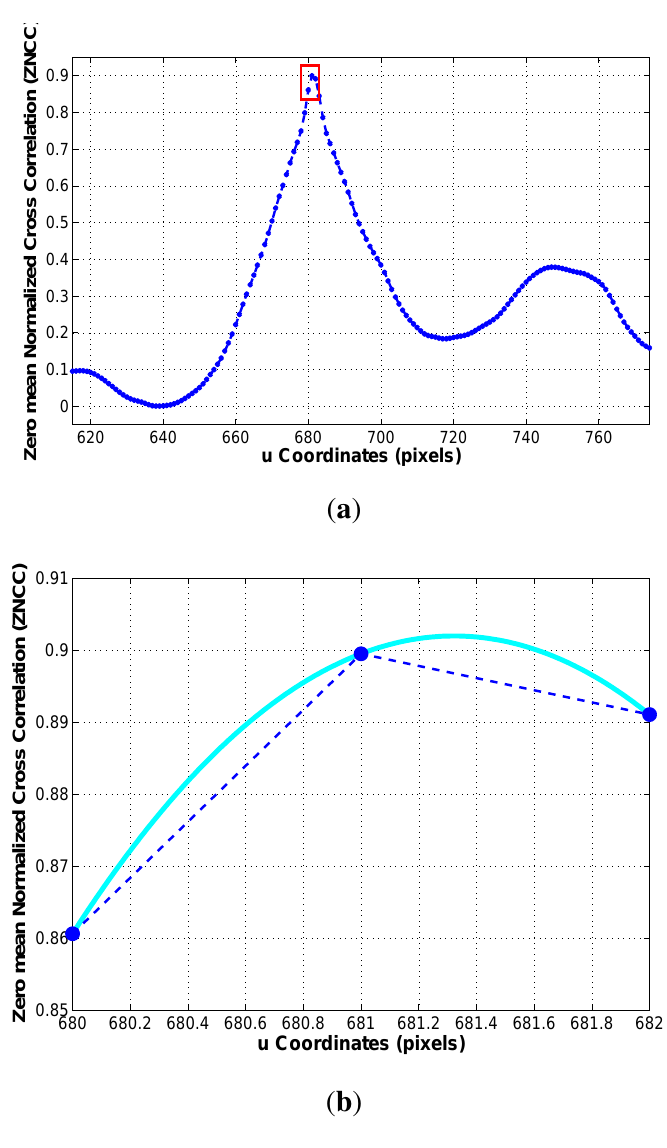
Figure 11. ( a ) Correlation function along the epipolar line; ( b ) Zoomed image around the global maximum and second degree polynomial approximation for getting subpixel